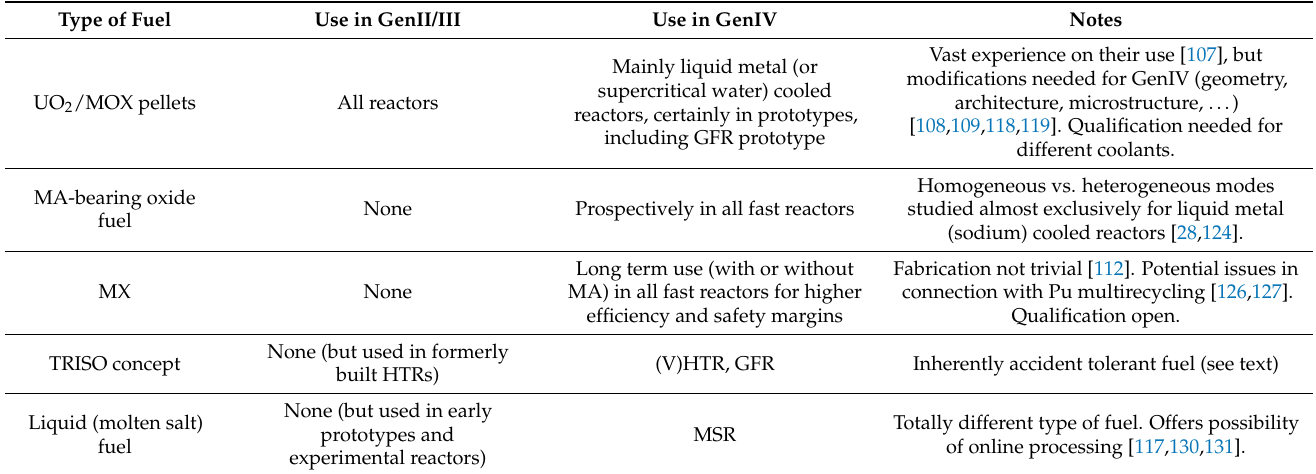
Table 3. Summary of classes of fuels through reactor generations. MOX = mixed U-Pu oxide fuel, MA = minor actinides, MX = carbides, nitrides, silicides, ..., TRISO = TRi-structural ISOtropic particle fuel, (V)HTR = very high temperature reactor, GFR = gas-cooled fast reactor, MSR = molten salt